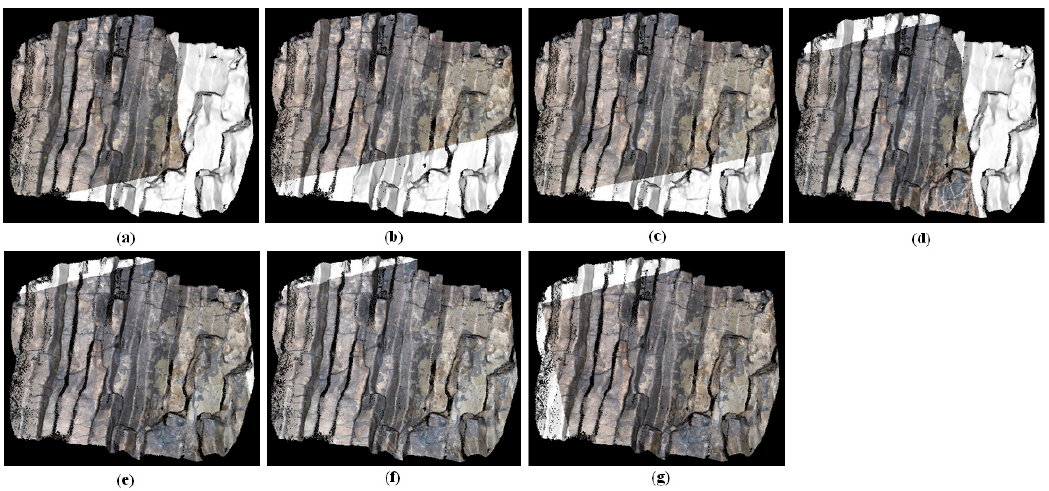
Figure 14. 3D visualization of the mapping relationship between TLS point cloud and images.